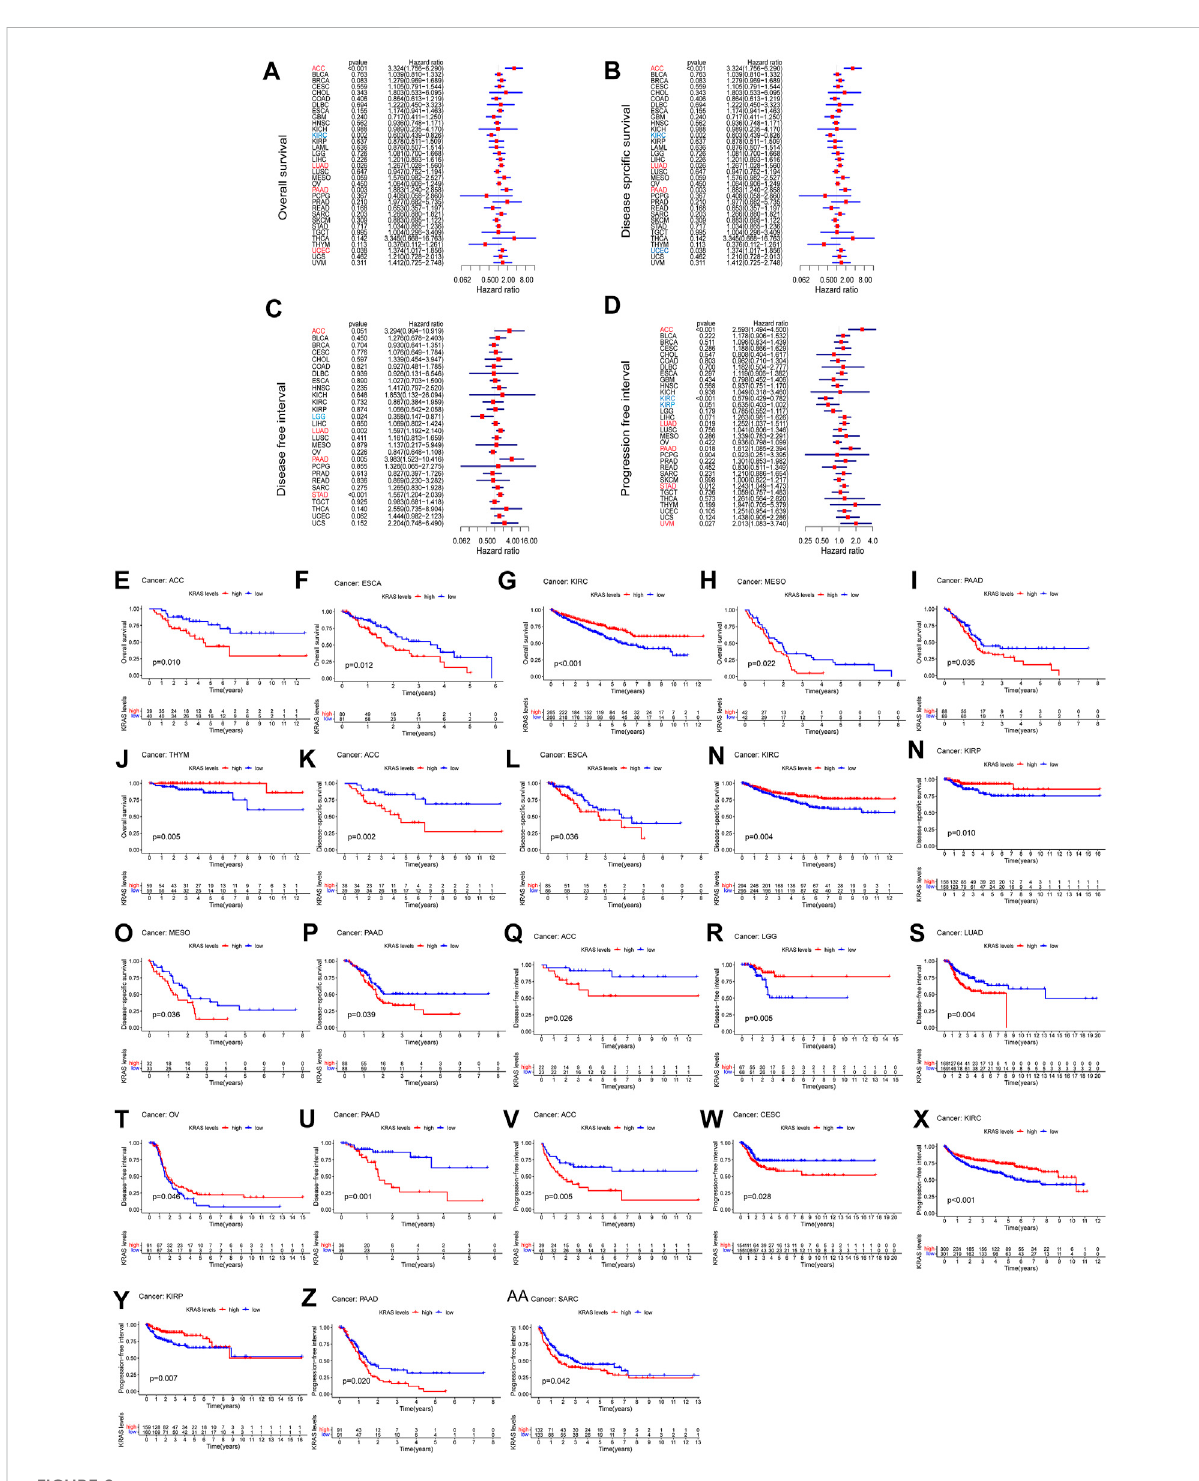
FIGURE 2 The relationship between the expression of KRAS and the prognosis of patients with 33 kinds of cancers in the TCGA database. (A,E – J) OS (overall survival) (B,K – P) DSS (disease-speci fi c survival) (C,Q – U) DFI (disease-free interval) (D,V – AA) PFI (progression-free